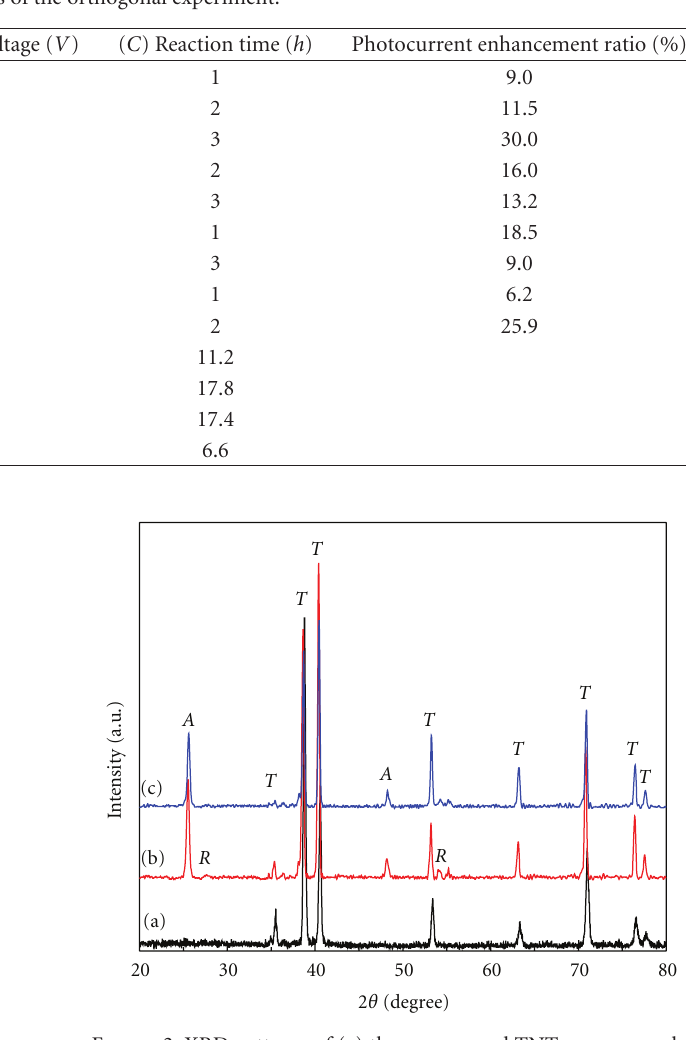
Figure 2: XRD patterns of (a) the as-prepared TNT arrays sample, (b) the undoped TNT arrays sample annealed at 450 ◦ C for 3 h, and (c) N-doped TNT arrays sample after annealing at 450 ◦ C for 3h. The doping conditions are that reaction voltage is 3V, reaction time 3 h, and electrolyte concentration 0.5 M. A , R , and T represent anatase, rutile, and titanium,